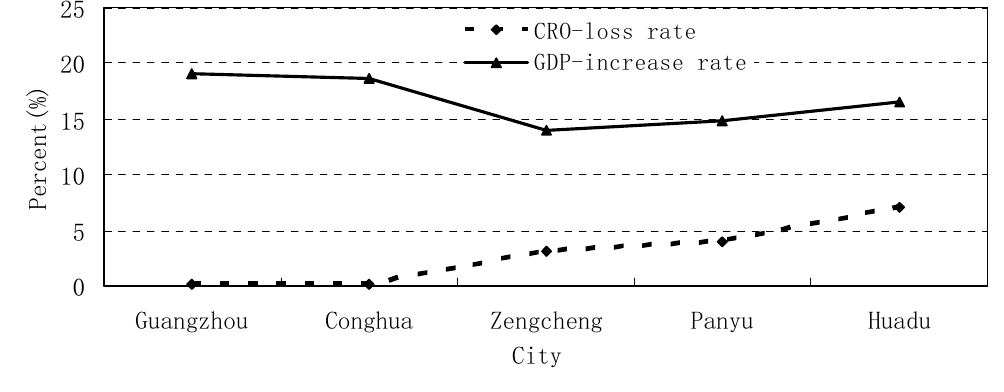
Figure 8. The relationship between cropland loss rate and GDP growth